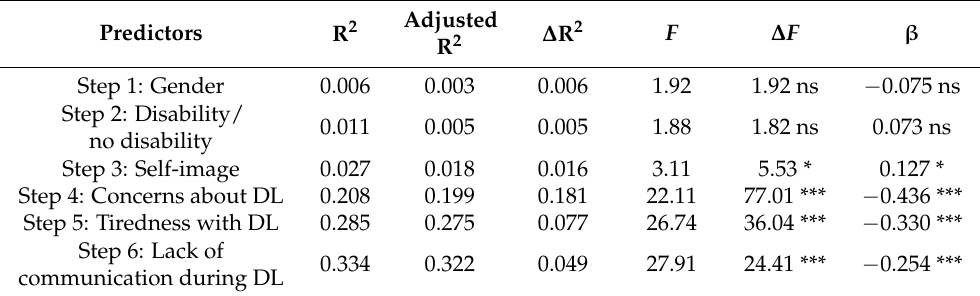
Table 3. Multiple regression analysis of demographics, self-image, concerns about distance learning, tiredness with distance learning, and lack of communication during distance learning on students’ perspectives on distance learning.